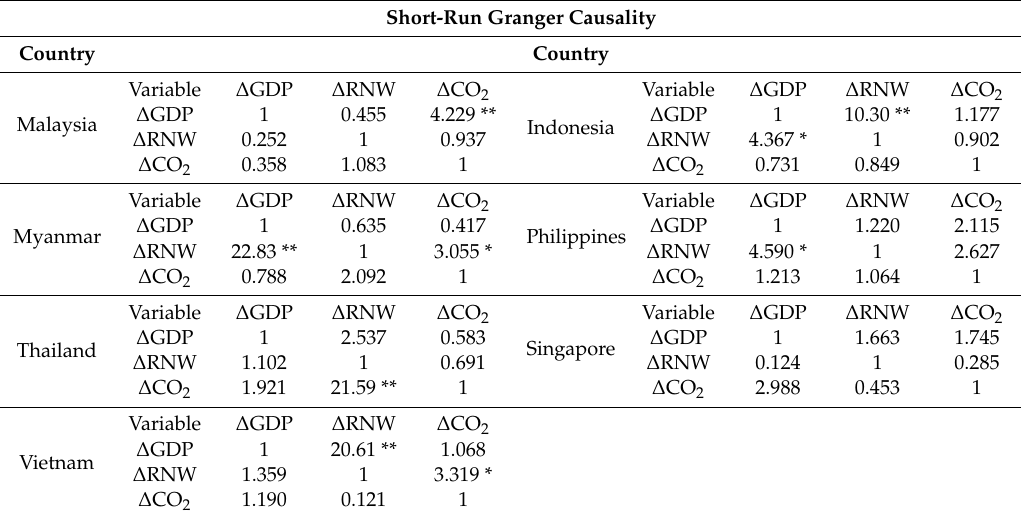
Table 6. Results of panel Granger causality test identifying long-run relationships between CO 2 emissions, real GDP, and renewable energy production for ASEAN countries. Short-Run Granger Causality Country